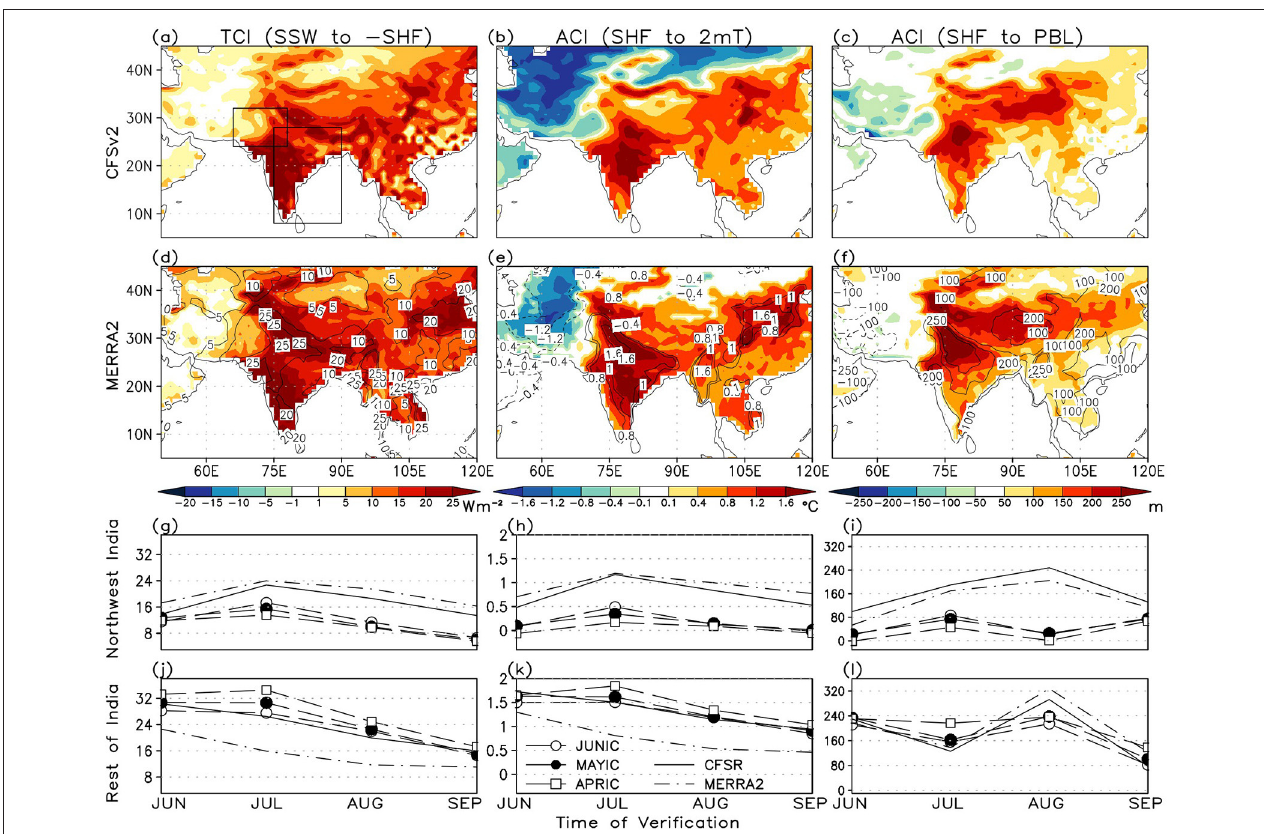
FIGURE 8 | (a) Terrestrial coupling index (TCI) for 2m temperature (2 mT) based on SSW and SHF and (b) the corresponding atmospheric coupling index (ACI) based on SHF and 2 mT from CFSv2 JUNIC hindcasts. (c) shows the ACI for PBL height. Units are Wm − 2 , ◦ C, and m, respectively. (d–f) respectively, shows the same for CFSR (shaded) and MERRA2 (black contours). (g-i) and (j-l) show the monthly coupling indices in JJAS for the northwest and rest of India domains, respectively; from JUNIC, MAYIC and APRIC hindcasts, CFSR and